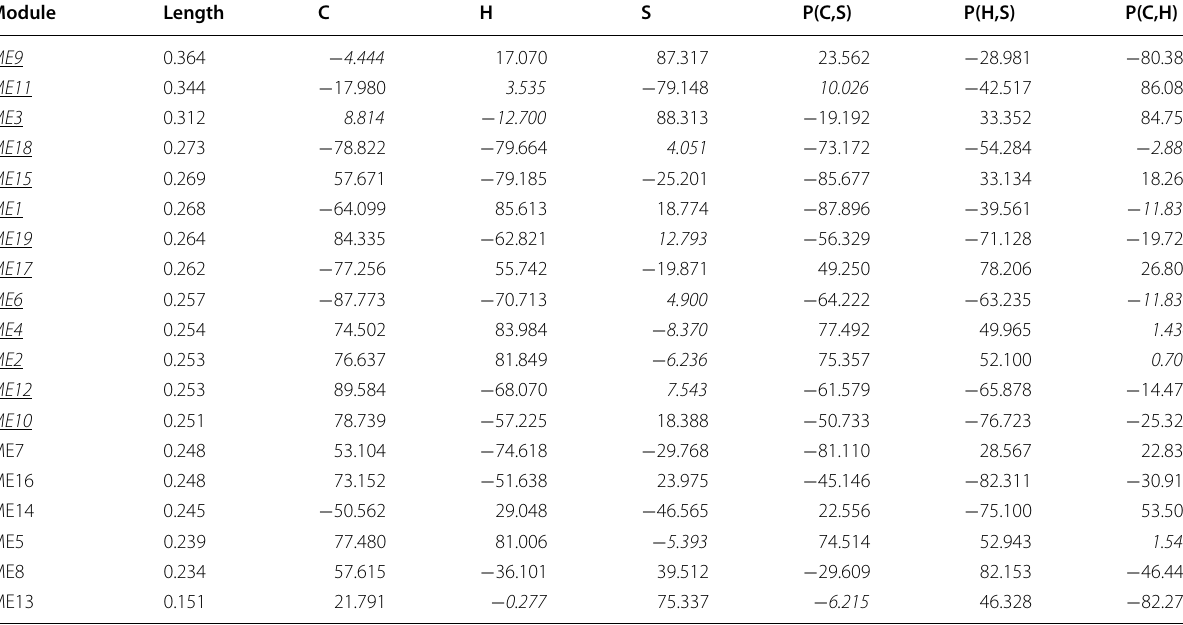
The italic underline gene modules had length greater than